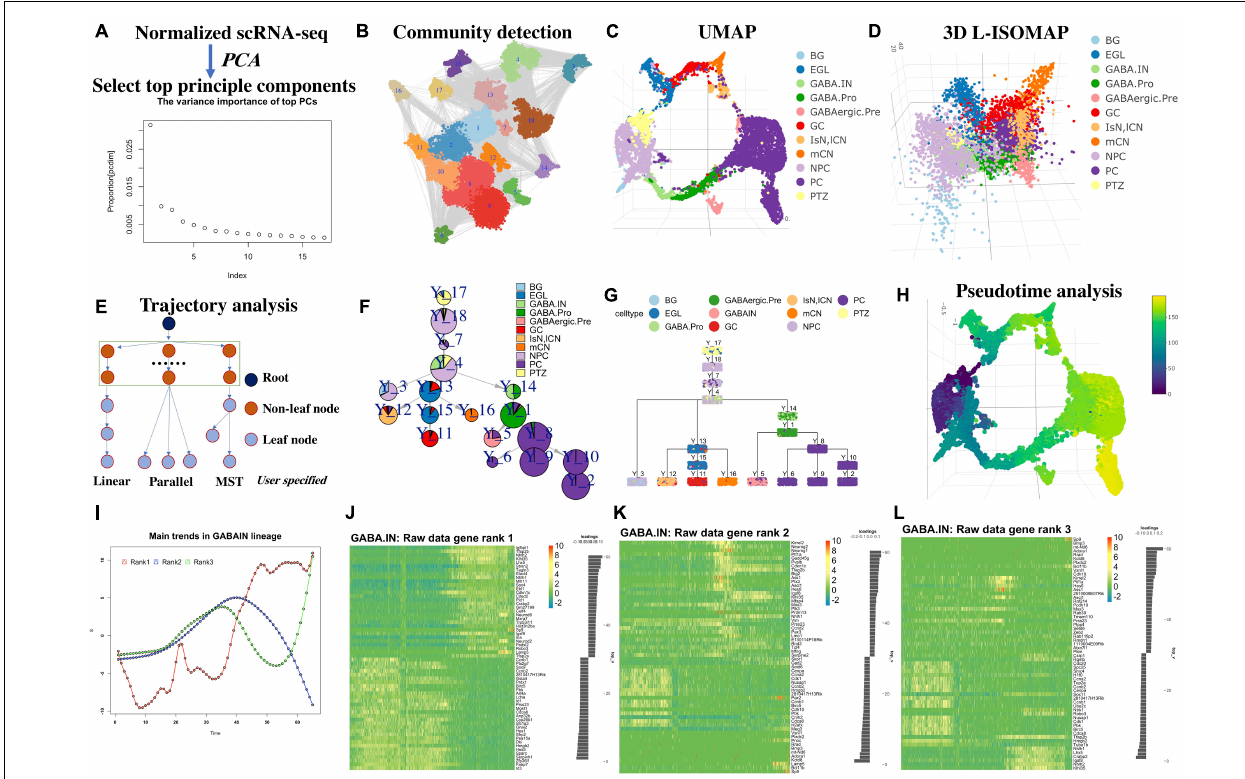
FIGURE 1 | Workflow of LISA2 and cerebellum trajectory analysis. (A) PCA and principal component selection. (B) Community detection for clustering based on k -nearest neighbors (kNN) graph. (C) Visualizing in UMAP and (D) 3D L-ISOMAP. (E) Trajectory building in LISA2 by specifying root and leaf node structure [linear, parallel, and minimum spanning tree (MST)]. (F) Trajectory visualization by pie tree plot. (G) Trajectory visualization by cell cluster tree plot (each box is a cluster marked by Y_cluster ID, each point represents a cell). (H) Pseudotime visualization. (I) Gene expression trend analysis by principal trend analysis (PTA) in GABA.IN branch. PTA was applied to the GABA.IN branch to identify main gene expression trends (red, blue, and green) from rank 1 to rank 3. (J–L) Heatmap shows gene expression trend of the GABA.IN branch discovered by PTA in ranks 1, 2, and 3. The root cell type PTZ is in yellow in UMAP and 3D-ISOMAP. The leaf cells are divided into three branches. GCs, mCN, and IsN/lCN are derived from EGL. PC is derived from GABAergic.Pre. BG is derived from NPC. We chose linear structure for BG; parallel structure for GC, mCN, and IsN/lCN; tree structure for PC cells. BG, Bergmann glia; EGL, external granule layer cells; GABA.pro,